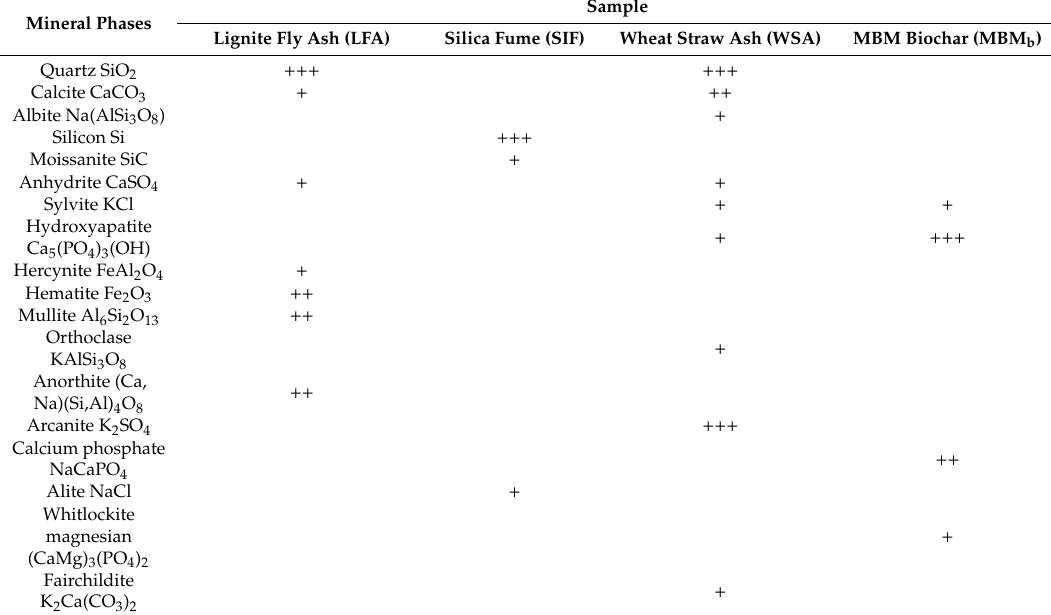
Table 3. Mineralogical analysis of ash